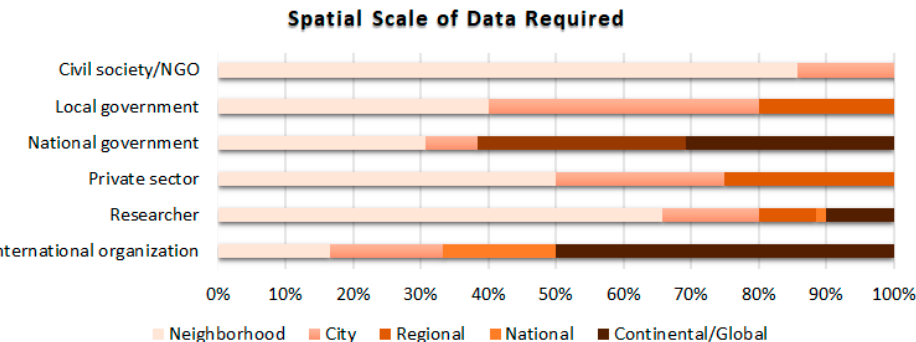
Figure 10. Results of online expert survey on the required temporal granularity of maps on deprived areas (in %) (N = 112).